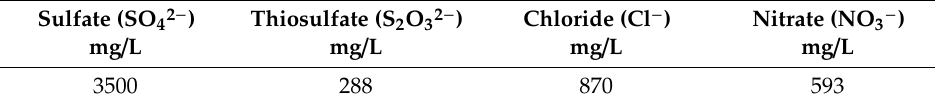
Table 2. Concentration of ions in synthetic water used in laboratory scale adsorption tests.